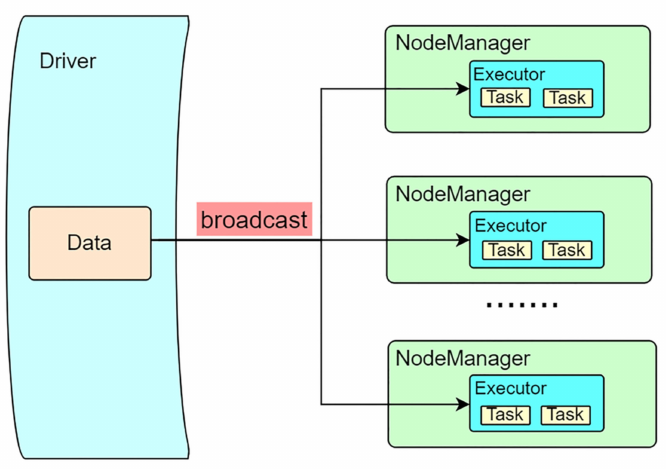
Figure 5. The principle of distributing data to executors via